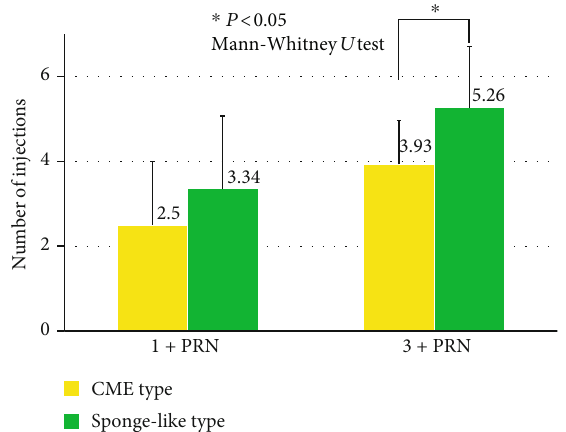
Figure 6: Comparisons of the total number of injections in eyes with CME to that with sponge-like DME at 12 months. In the 1 +PRN group, there was no signi fi cant di ff erence between CME and sponge-like DME ( 2 : 5 ± 1 : 5 vs. 3 : 3 ± 1 : 7 ; P = 0 : 075 , Mann- Whitney U test). However, in the 3+PRN group, the total number of injections in the eyes with sponge-like DME was signi fi cantly more than that in eyes with CME ( 5 : 3 ± 1 : 4 vs. 3 : 9 ± 1 : 0 ; P = 0 : 0063 , Mann-Whitney U test). PRN: pro re nata ; CME: cystoid macular